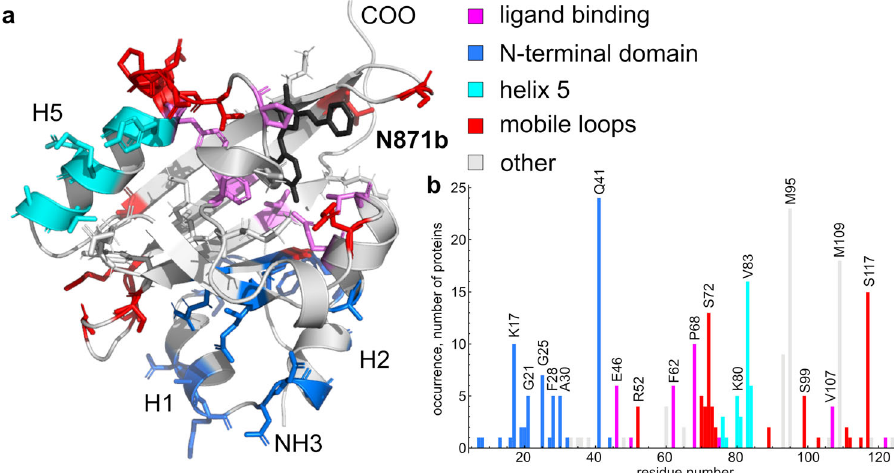
Fig. 6 Analysis of previously published FAST mutations. a Structure of the FAST/ N871b complex. Sidechains of residues that were mutated in any of the enhanced FAST variants are shown by sticks and colored with respect to the presumed role of the mutation. Ligand is shown in black. b Occurrences of mutations at certain positions in 58 reported enhanced FAST variants. In both panels, magenta corresponds to the residues, directly involved in the ligand binding; blue - to the residues that support the packing of the N-terminal domain; cyan - to the residues in the helix H5, red - to the residues in mobile loops. Gray denotes the mutations that do not fall in any of the listed groups. Figure is based on the data provided in the Supplementary Table